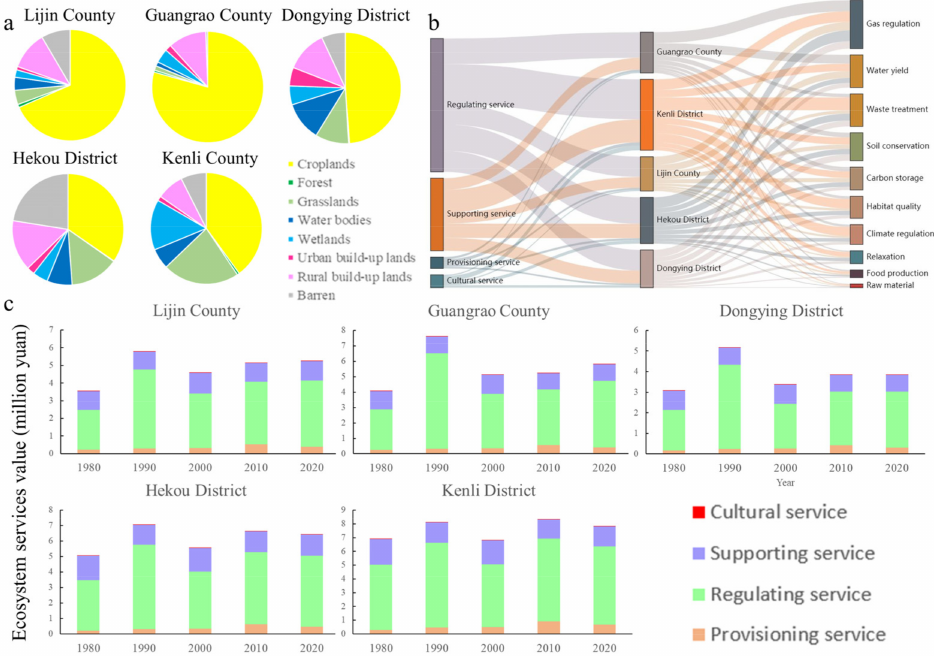
Figure 10. Structure of ecosystem services (ESs) in the Yellow River Delta (YRD). ( a ) Average share of land use/land cover in different administrative regions of the YRD, 1980–2020. ( b ) Sankey diagram of ESs in different administrative regions of the YRD, 1980–2020. ( c ) Temporal changes of ESs in different administrative regions of the YRD,